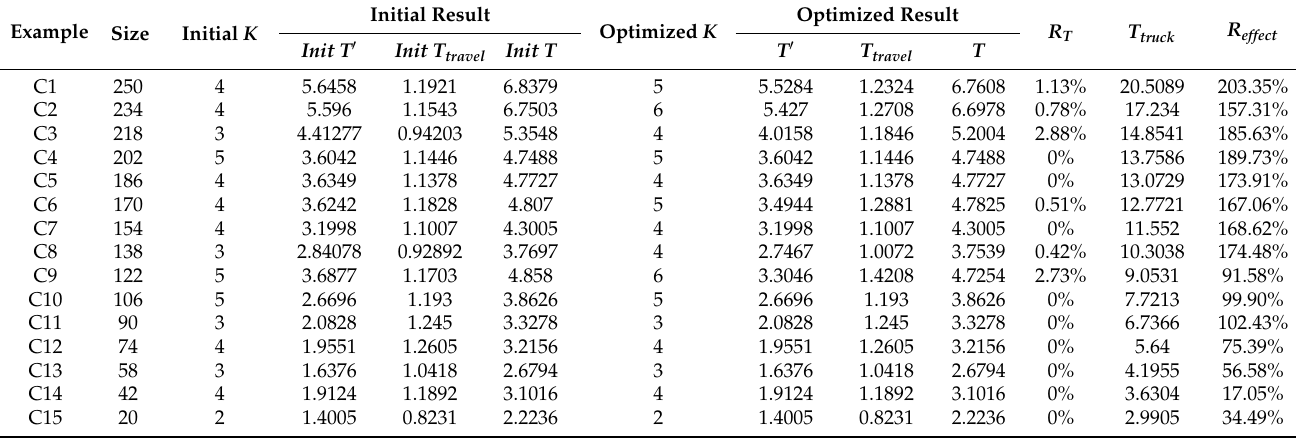
Table 3. Simulation results of the example.